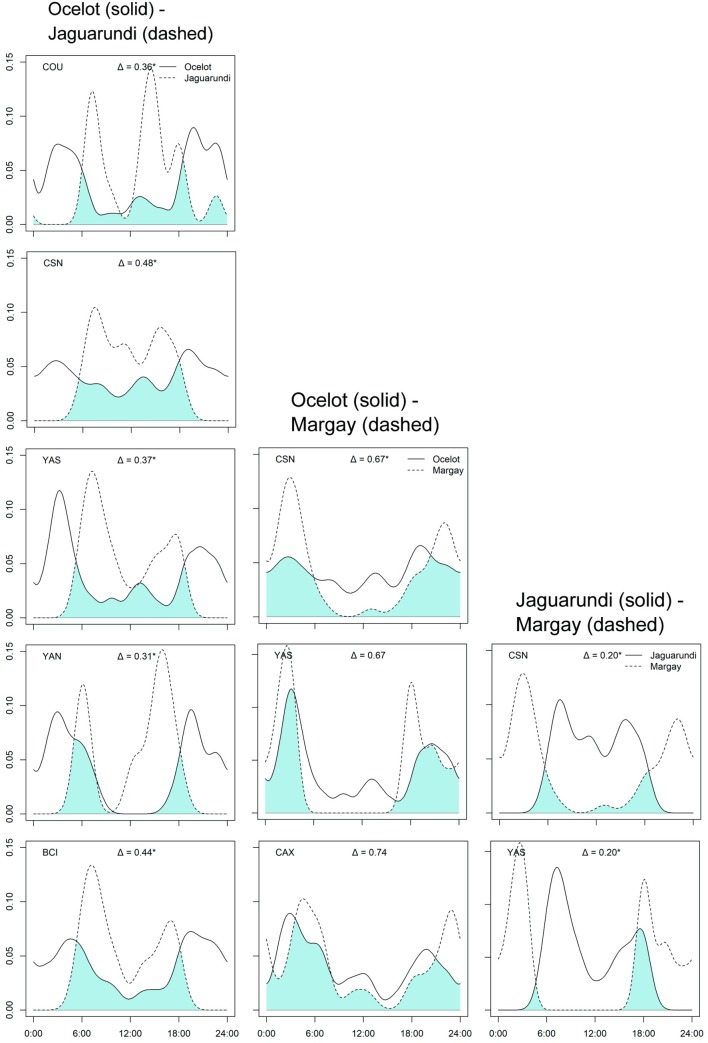
Coefficient of overlap in daily activity patterns between ocelot, jaguarundi and margay in Neotropical forest sites.X and Y axis represent time of the day and activity density, respectively. Overlap is represented by blue shaded areas and Δ is the coefficient of overlap (varying from 0 –no overlap to 1 –total overlap). (*) indicates significant differences. Study site is indicated in the top left corner.